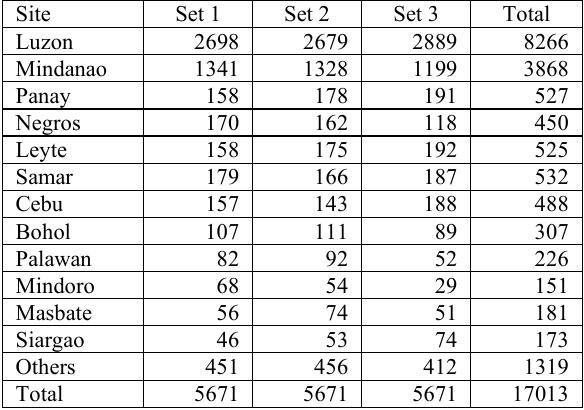
Table 1. Number of GCPs used in the FABDEM